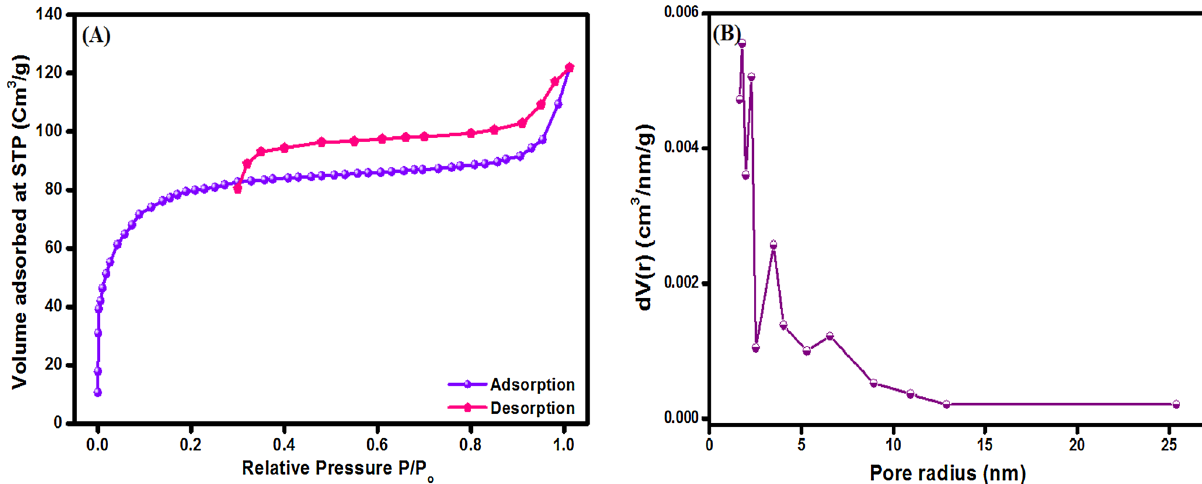
Figure 6. ( A ) N 2 adsorption/desorption isotherm and ( B ) pore size distribution of MIL-125(Ti)/MIL-53(Fe)/ CNT@Alg composite